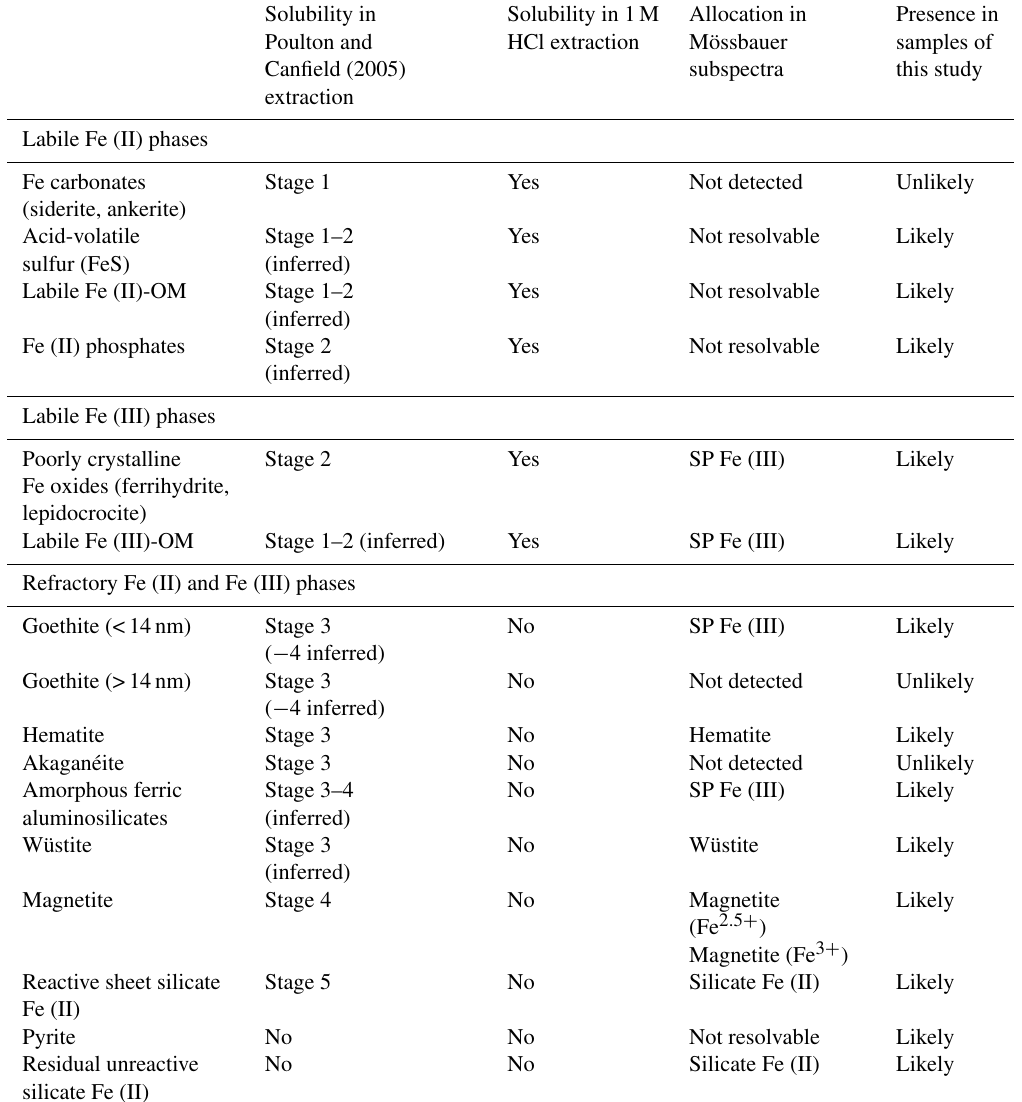
Table 3. Scheme for the interpretation of sedimentary Fe phases based on the extraction protocols and Mössbauer data. Solubilities in the Poulton and Canfield (2005) extraction listed as inferred indicate that these were not defined in the original protocol, but have either been investigated by later studies or are assumed for reasons described in the text. SP Fe (III) is superparamagnetic Fe